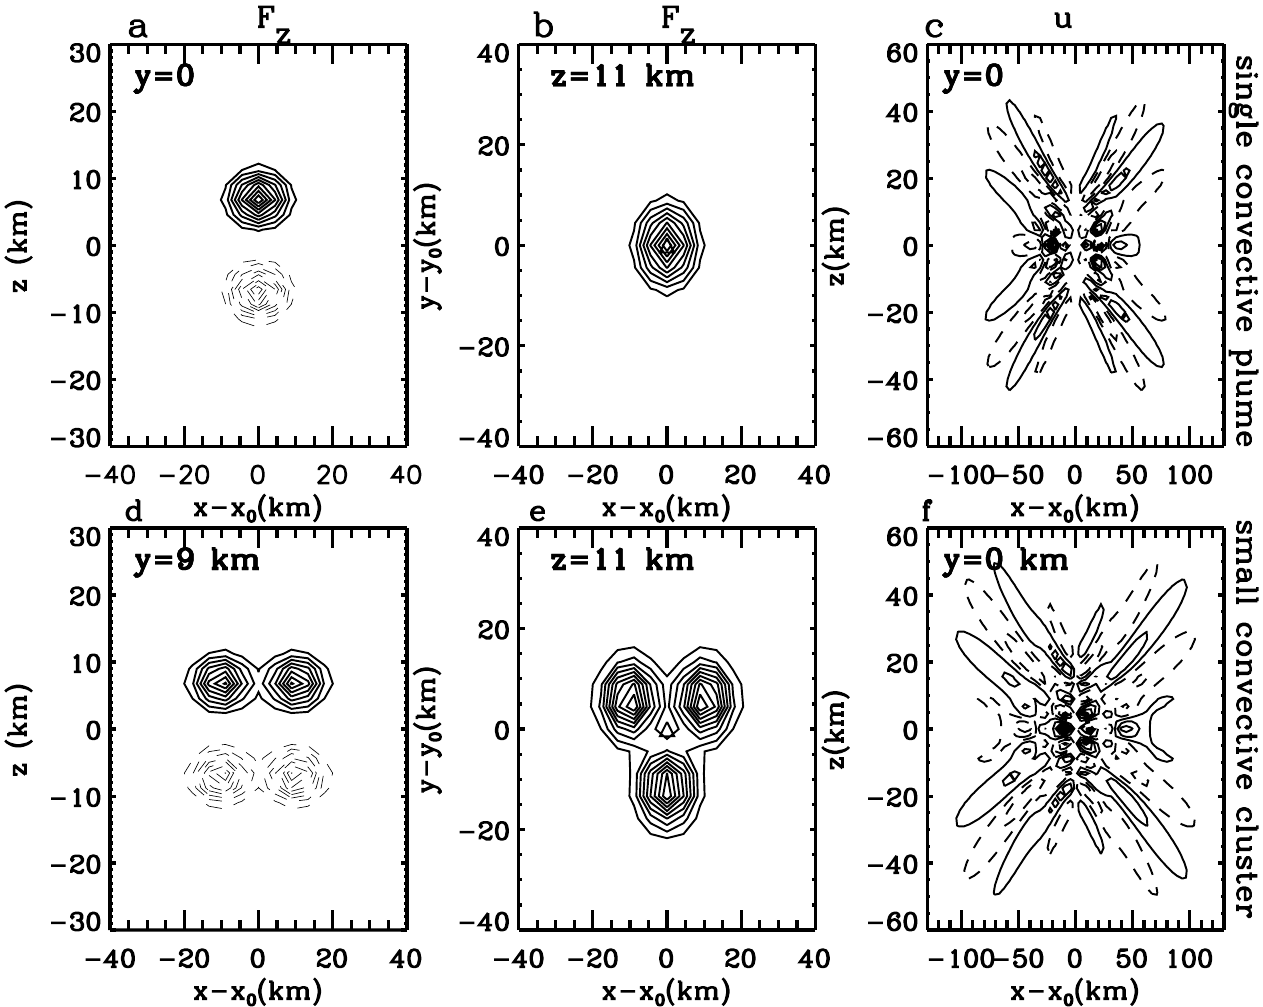
Fig. 3. Row 1: Single convective plume represented by a vertical body force and its image. Row 2: Small convective cluster represented by 3 vertical body forces and their images. Vertical slices of these body forces are shown at y =0 in (a) and at y =9km in (d) . Horizontal slices of these body forces at z=11 km are shown in (b) and (e) . GW zonal velocity perturbation contours are shown at t = 20min and y =0 in (c) and (f) . Body force contours are in intervals of 10% of the maximum value. Contours for the perturbation velocities are shown at 10, 30, 50, 70, and 90% of the maximum value. Solid lines indicate positive values, and dash lines indicate negative values. The maximum values in (c) and (f) (unscaled, with a constant background density) are 0 . 9 and 1 . 2m / s, respectively. The resolution is 1x = 4 .